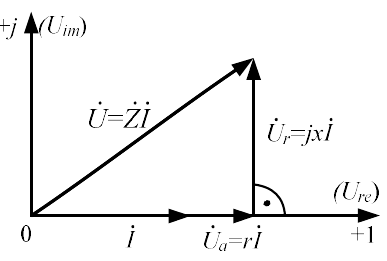
Figure 5. Voltages, a transformed vector diagram.